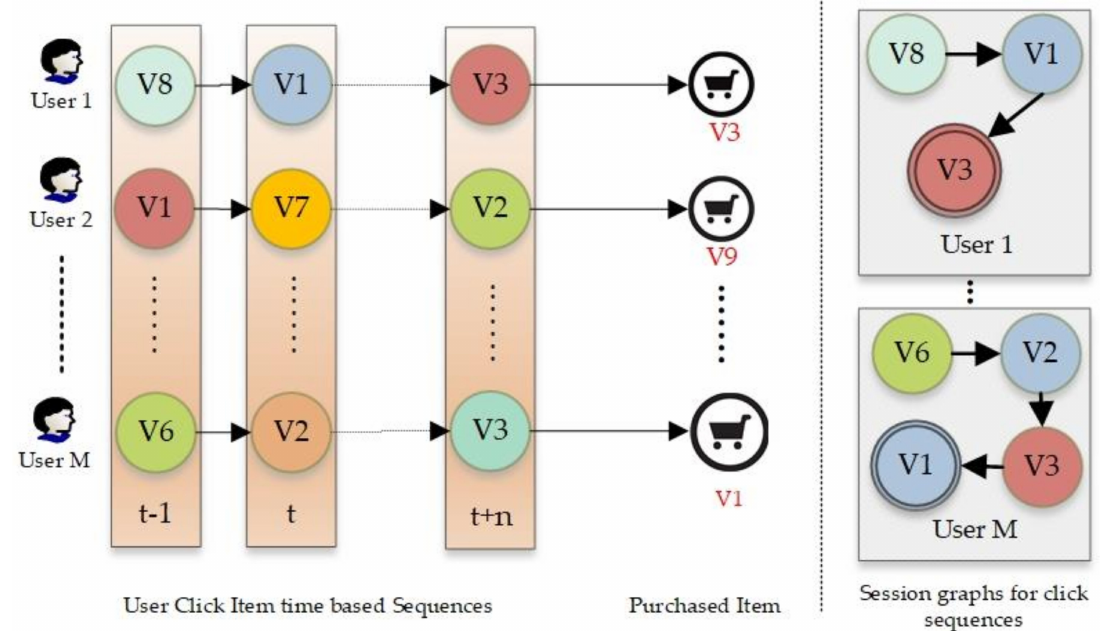
Figure 1. User click pattern on di ff erent graphs and respective session